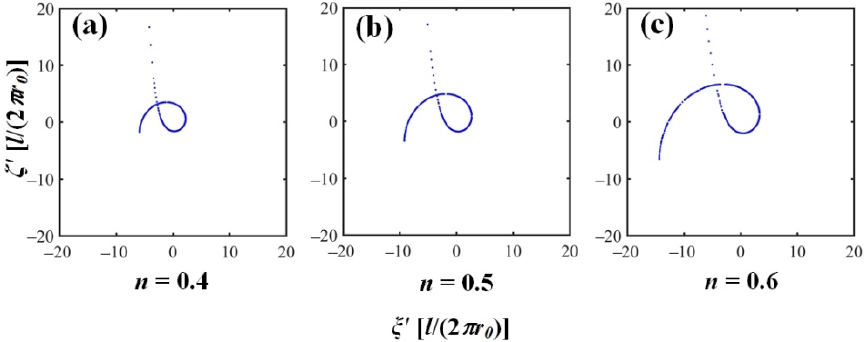
Figure 2. Spot diagram of the local spatial frequencies for l = − 5, ( a ) n = 0.4, ( b ) n = 0.5 and ( c ) n = 0.6.